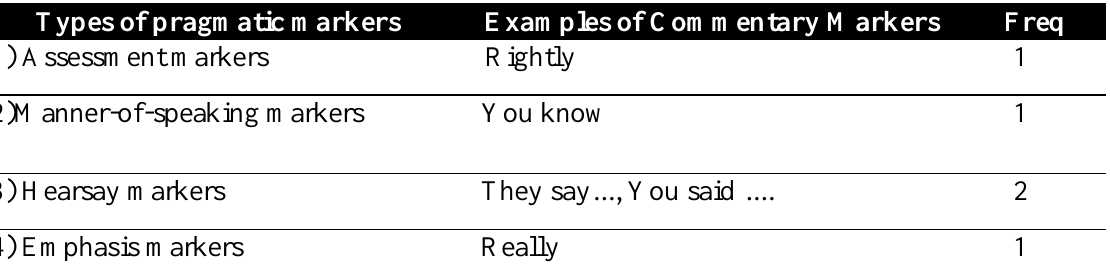
Table 2: Frequency Scale of Commentary Markers in